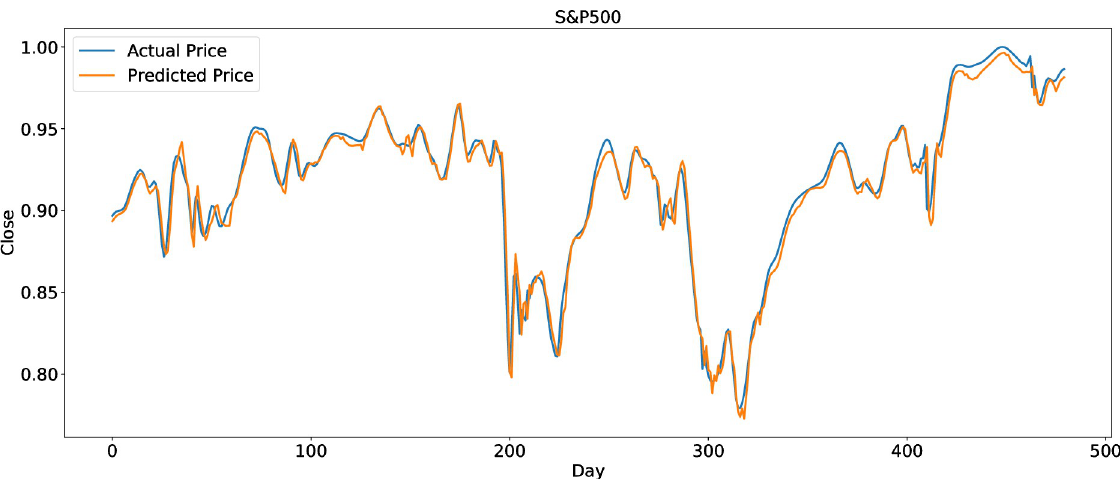
Fig 13. Prediction results of S&P data set.